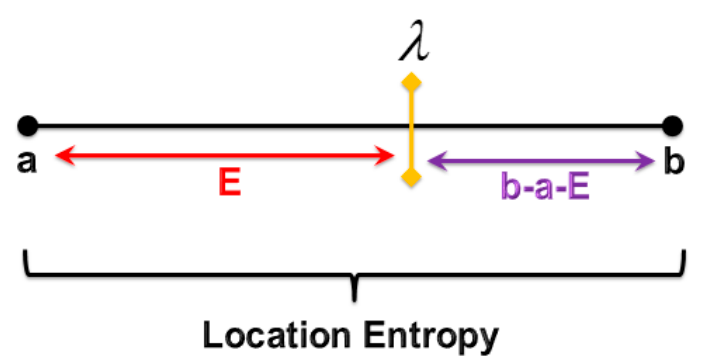
Figure 10. Our proposed privacy metric.